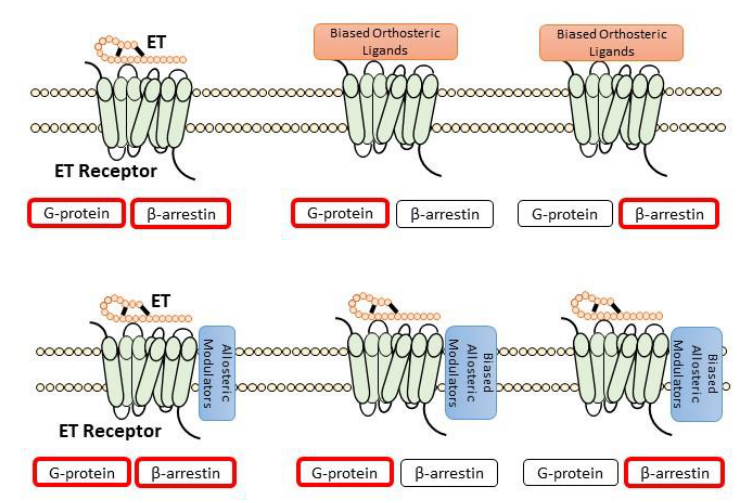
Figure 3. Pharmacologic mechanism of biased G-protein-coupled receptor signaling.